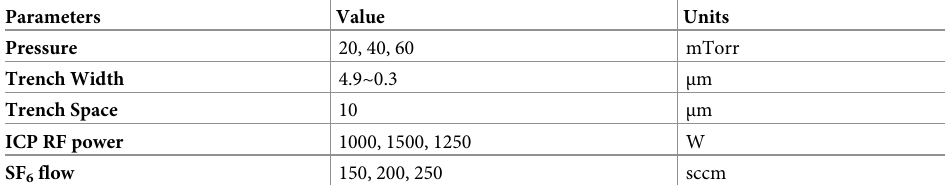
Table 2. The input features for the aspect-ratio dependent etching (ARDE) experiments for the 5-input dataset